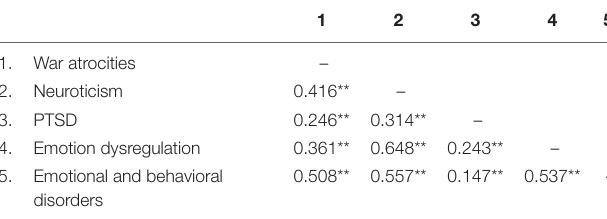
TABLE 1 | Intercorrelations of predictor, mediator, and outcome